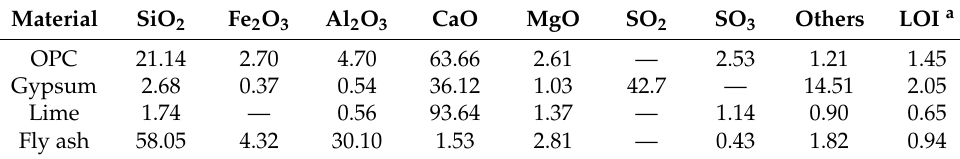
Table 2. Chemical compositions (wt.%) of raw materials